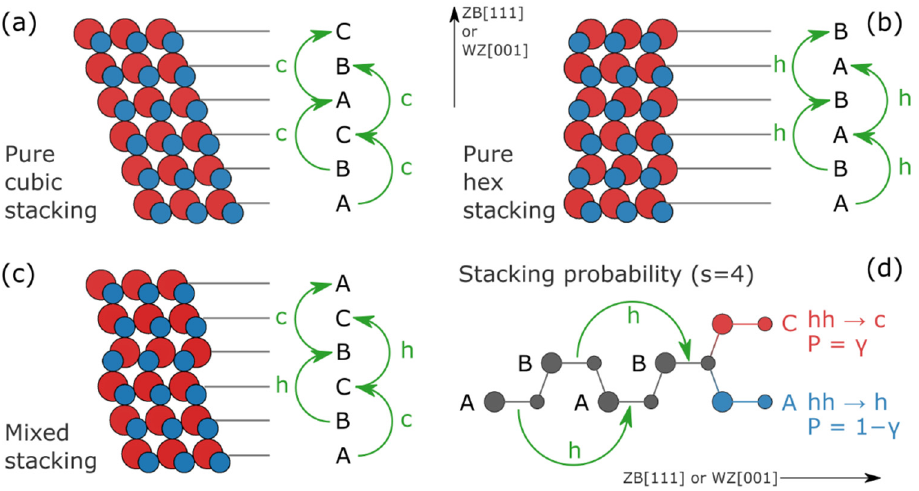
Figure 1. Sketches of ZB ( a ), WZ ( b ), and mixed stacking ( c ) structures, highlighting the different {ABC} n stacking sequences along [111] (cubic, c ) and {AB} n stacking sequences along [001] (hexagonal, h ). ( d ) An example of a stacking sequence associated with an SF probability parameter (P = γ and the related P = 1 − γ ) within the s = 4 formalism.